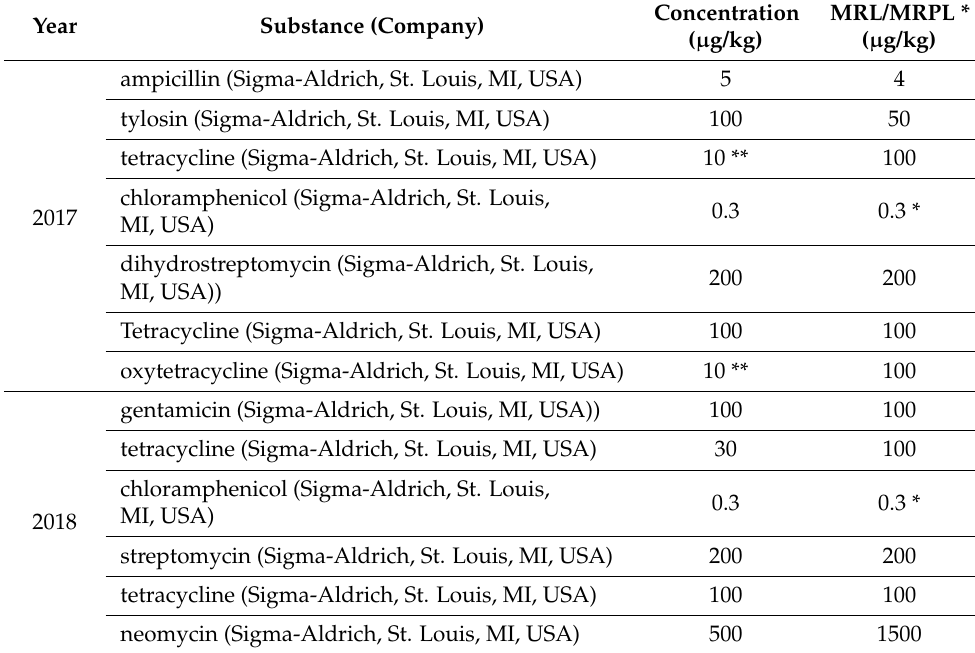
Table 1. Antimicrobial substances used for proficiency testing according to EU and CU requirements in